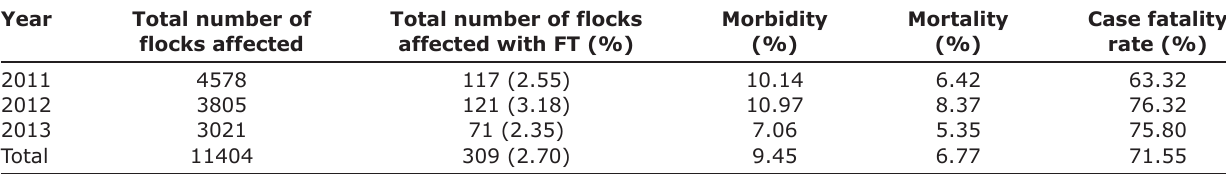
Table-1: Year wise percent morbidity, mortality, case fatality rate due to FT in broiler chicks in some parts of Haryana during 2011-2013.